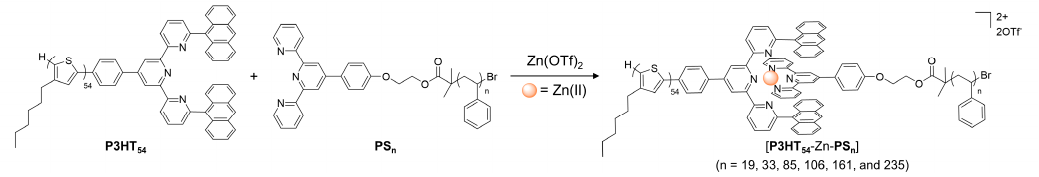
Figure 3. ( a ) 1 H NMR spectra of [ L2 –Zn– L3 ] and [ P3HT 54 –Zn– PS n ] (n = 19, 33, 85, 106, 161, and 235). 19 red, oxygen; yellow, zinc). Hydrogen atoms and OTf − ions are omitted for clarity. ( b ) Stacked diffusion 21